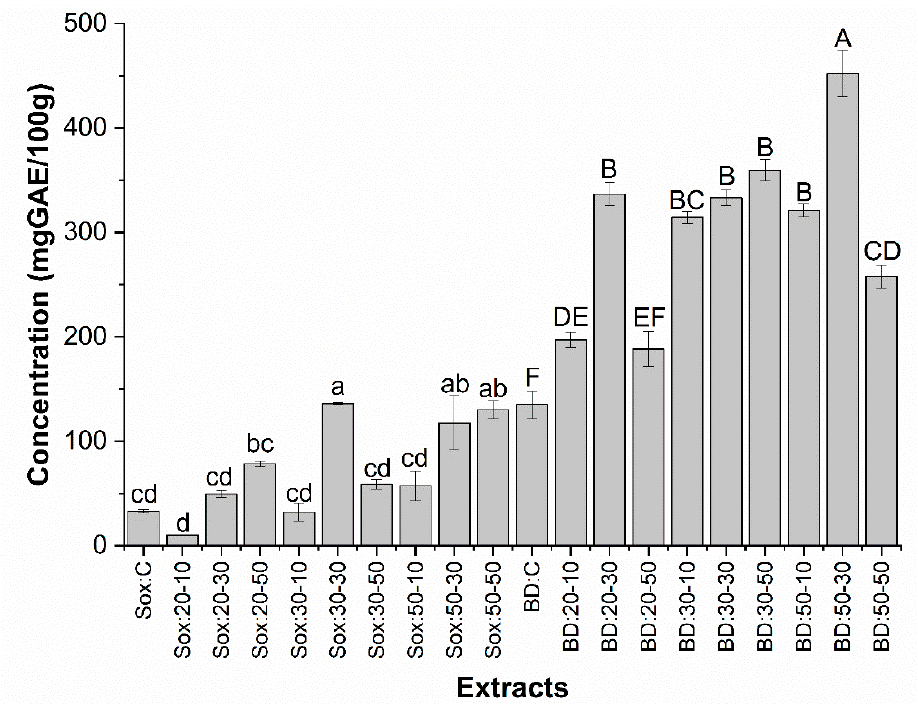
Figure 5. Determination of the total phenolic content of grape seed oils using different treatment conditions (ultrasound) obtained by low pressure methods (Sox and BD). The bars in each column represent the standard error. Samples with the same letter for the same method no significant difference (p > 0.05) by the Tukey test with 95% confidence.